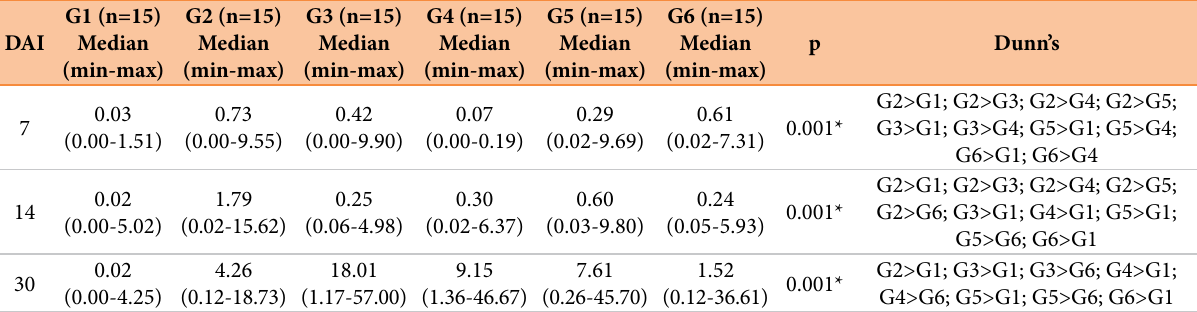
Table 4 - Quantitative analysis of collagen fibers deposition in partial thickness burn wounds experimentally induced in Wistar rats and treated with silver-based dressings.